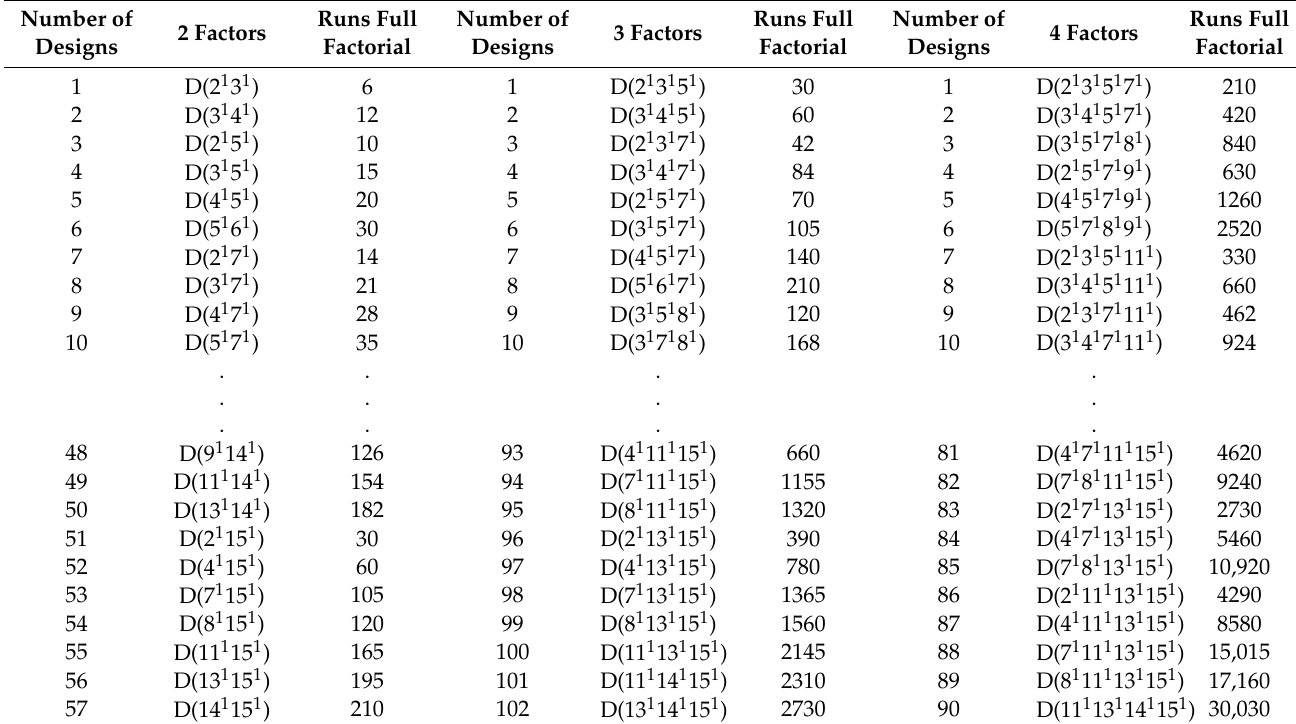
Table 1. Examples of pure asymmetrical arrays with 2 to 4 factors.